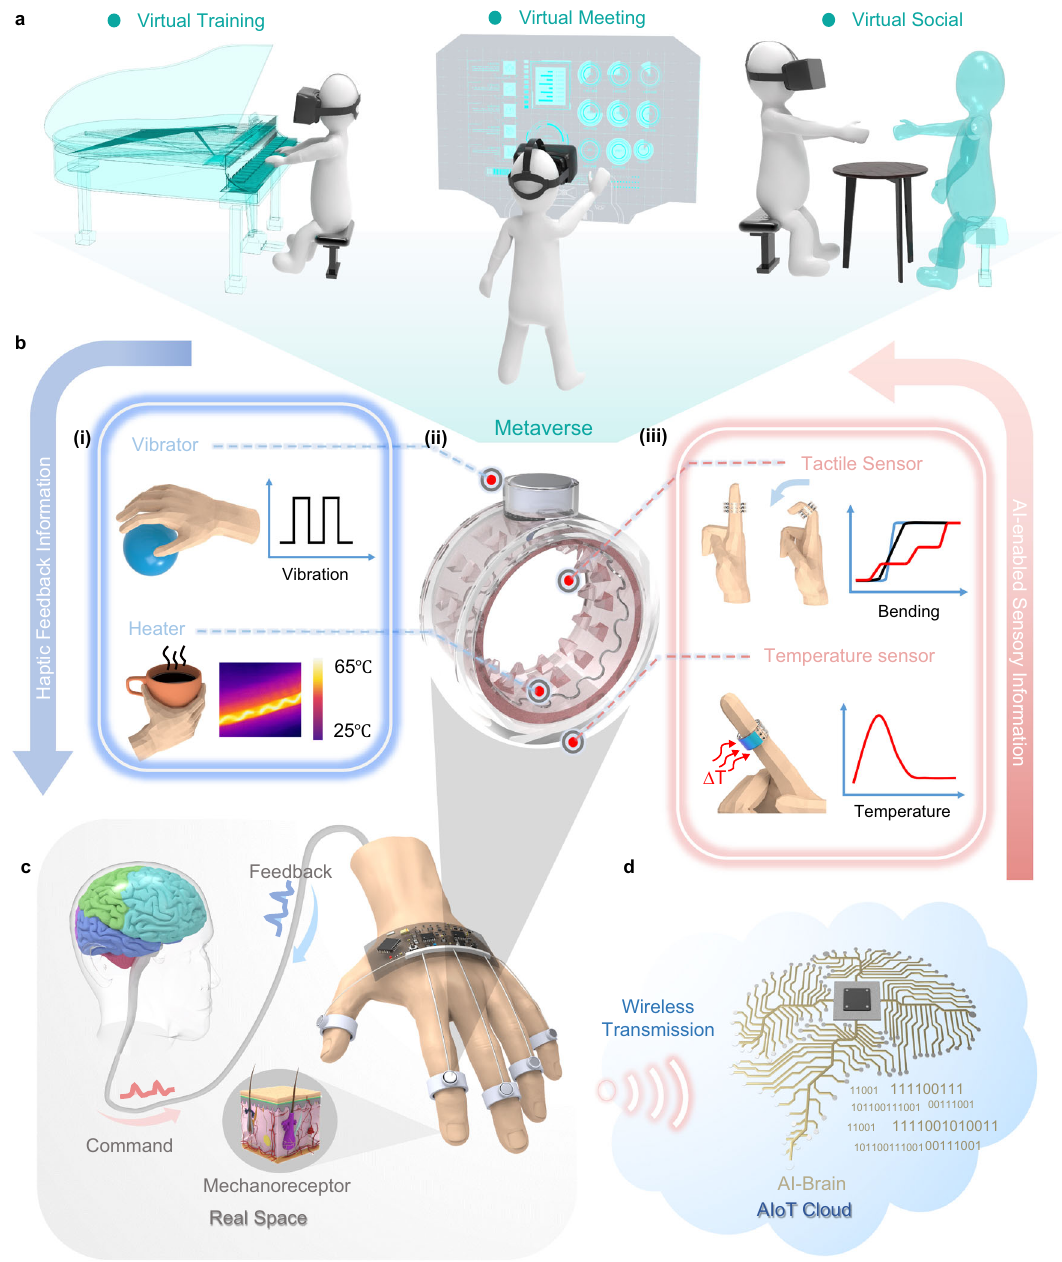
Fig. 1 | The ATH-Ring based intelligent system with multimodal sensing and feedback functions. a Illustration of the metaverse virtual space for augmented entertainment, education and social experience. b (i) The feedback functionality achieved by the integrated vibrator and heater. (ii) The detailed structure of the